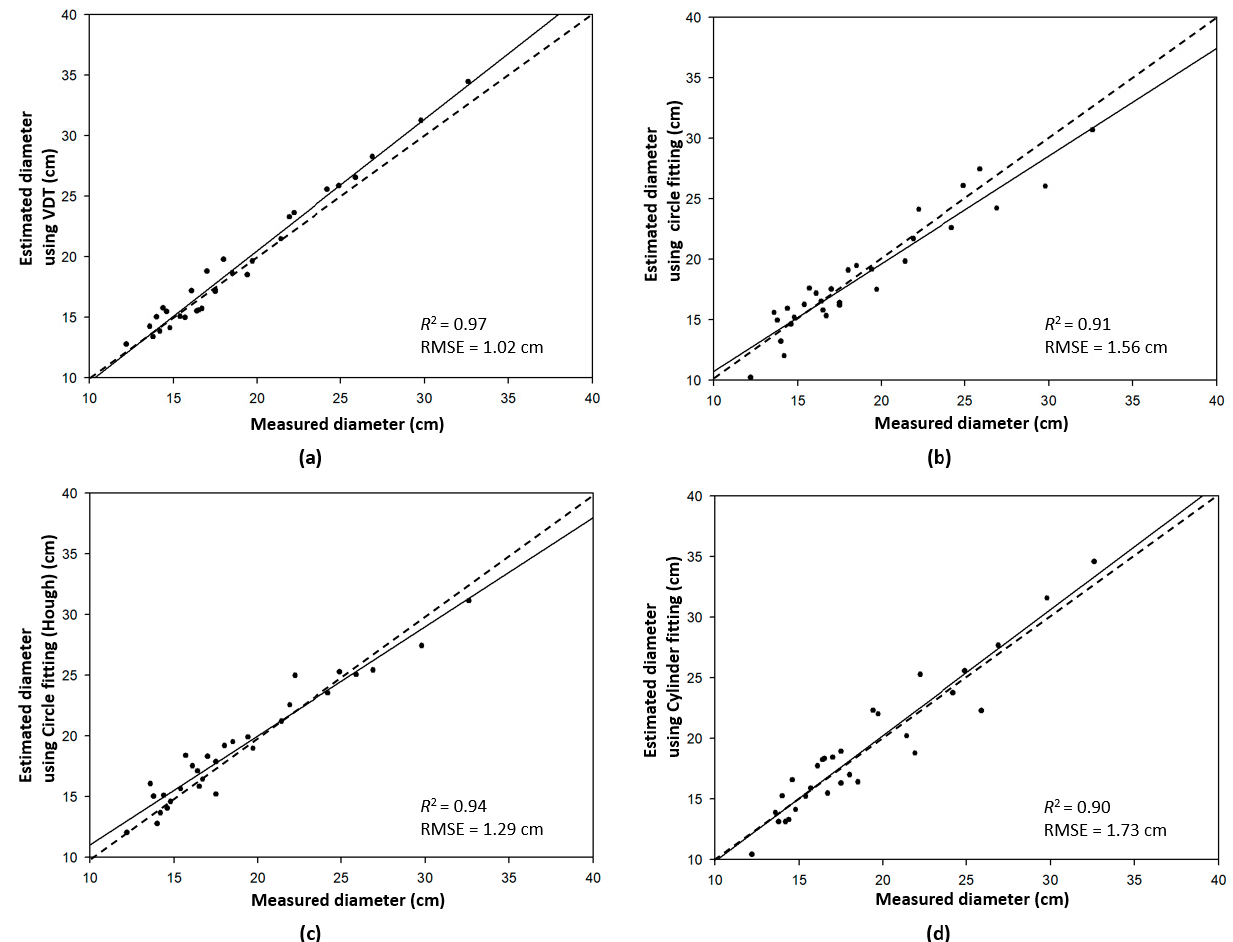
Figure 7. The results of VDT measurement compared with reference methods. ( a ) VDT measurement; ( b ) cylinder fitting method; ( c ) circle fitting method; ( d ) a revised circle fitting method. In the figure, VDT refers to virtual diameter tape; R 2 refers to the coefficient of determination; RMSE refers to the root mean square error.